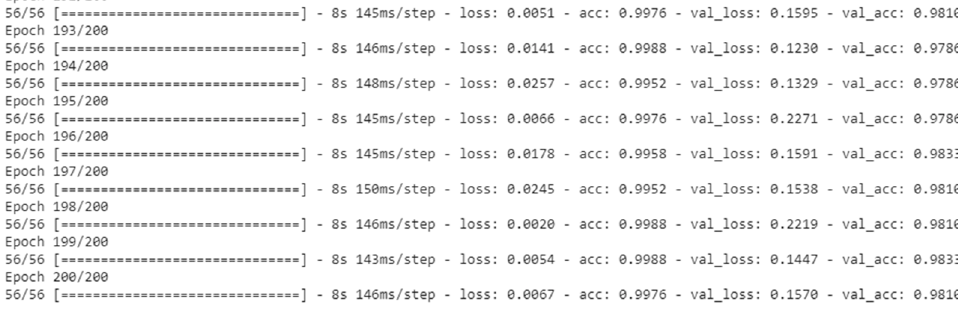
Figure 5. Showing ResNet50 training process using fine-tuning .